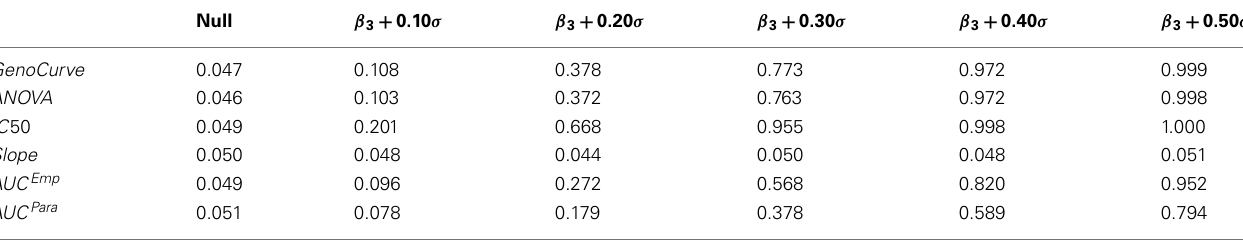
Table 3 | Power estimates at α = 0.05 under the alternative using estimated parameters for various effect